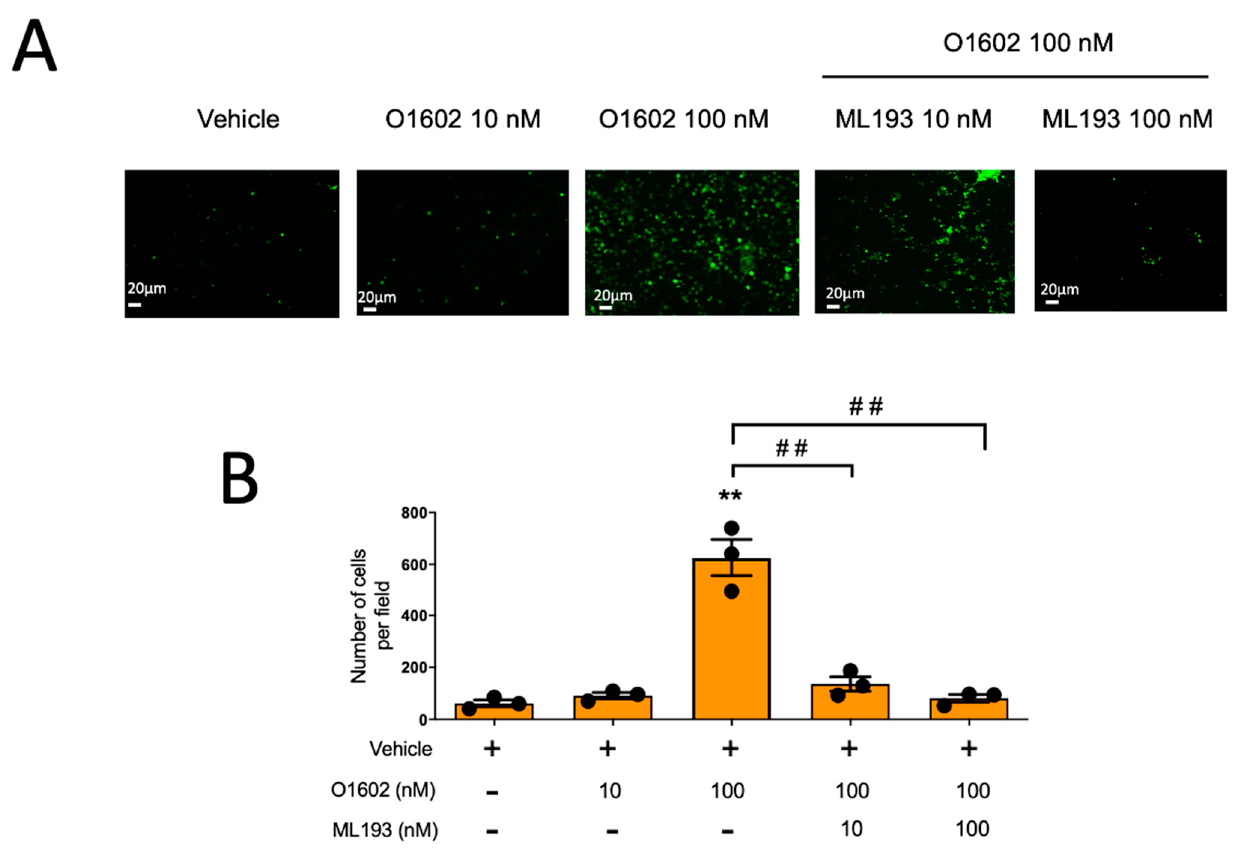
Figure 5. GPR55-specific agonist O1602 causes GPR55-dependent migration in BMMCs. Panel ( A ): representative image of a filter obtained in a migration assay of BMMCs towards distinct concentrations of O1602 alone or in the presence of ML193. Panel ( B ): quantification of cell migration of BMMCs towards O1602; ** p < 0.01 vs. vehicle; ## p < 0.01 vs. O1602.